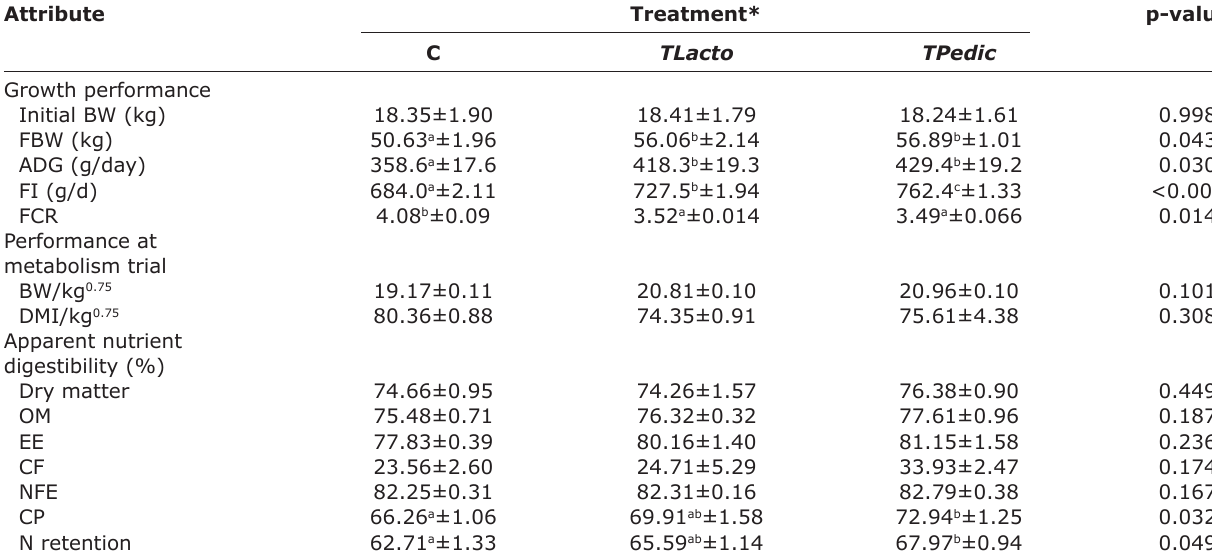
Table-2: Effect of probiotics on growth performance and nutrient digestibility in grower pigs.